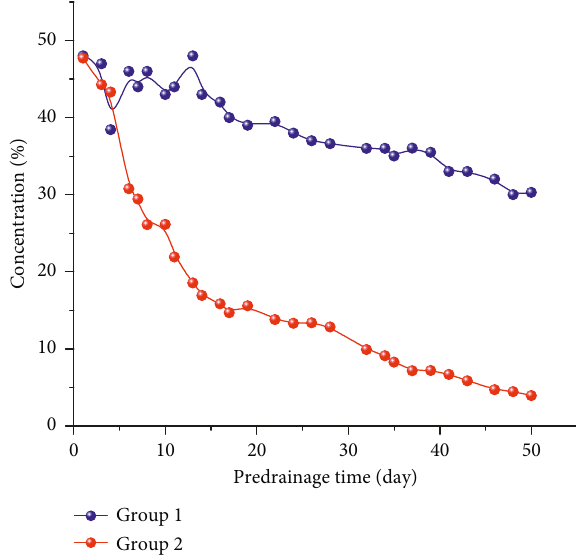
Figure 12: Gas drainage concentrations in the field